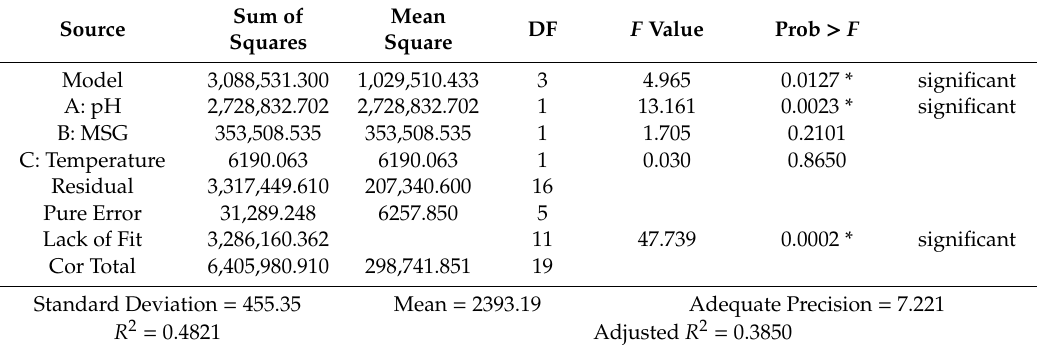
Table 3. Analysis of variance (ANOVA) results for the actual responses using the CCD linear model for GABA production of B. cereus